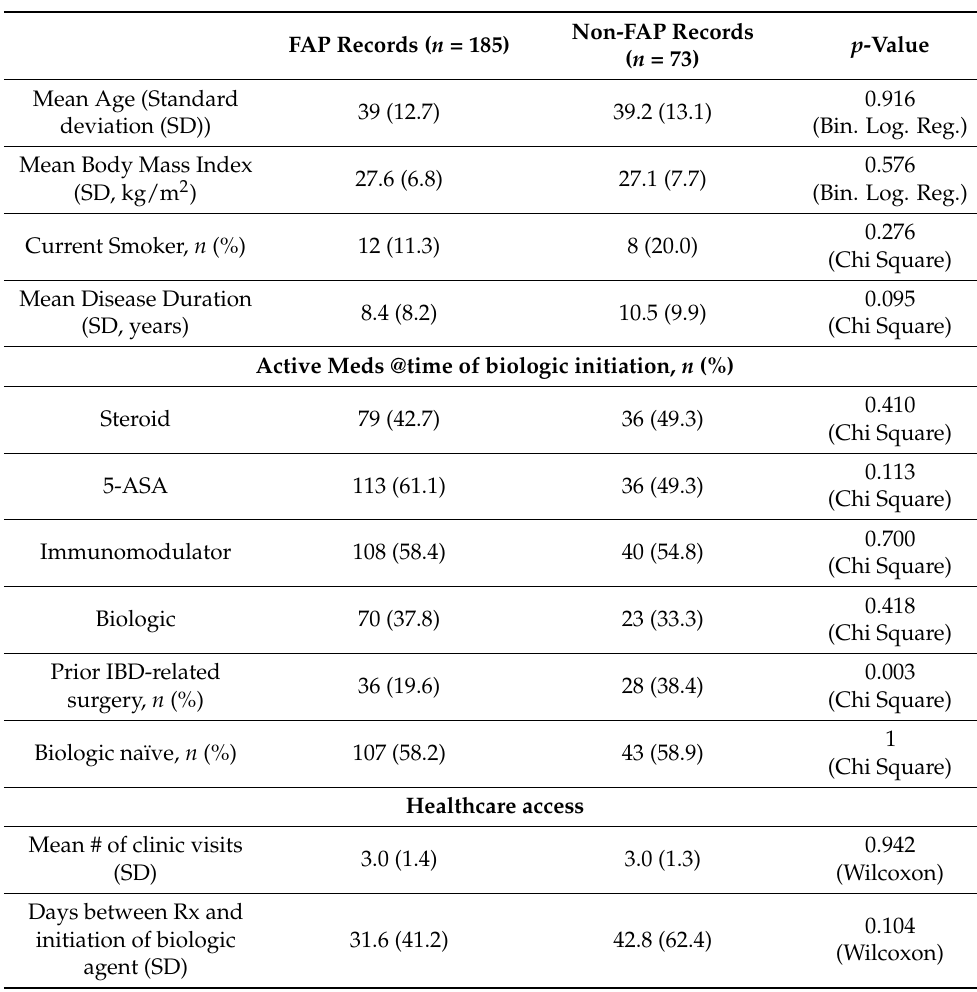
Table 1. Cohort demographics and differences between IBD records with and without financial assistance program (n = number of unique biologic